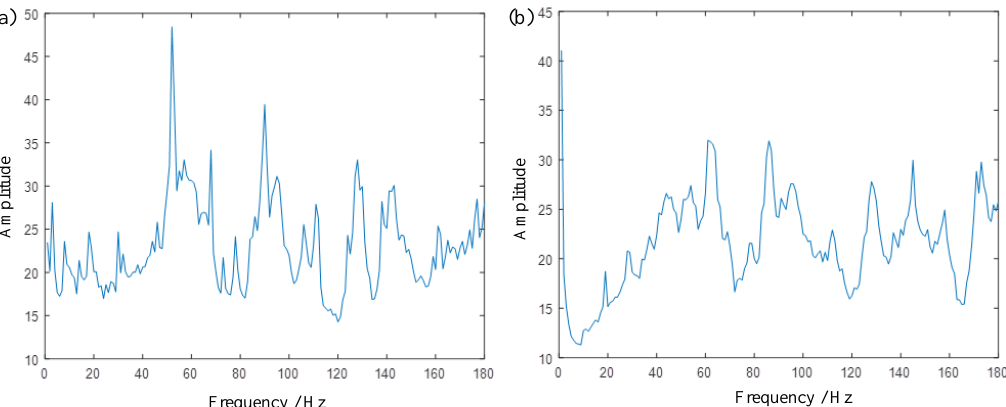
Figure 7. ( a , b ) are the 2D energy-frequency maps by SST and 4-SST based on the same algorithmic theory in Sections 2.2 and 2.3, respectively.